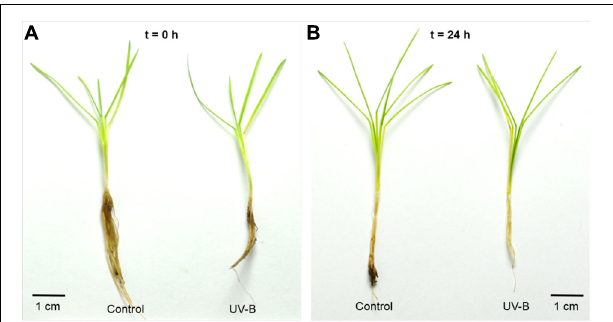
FIGURE 2 | Photographs of D. antarctica plants that were treated to a 1 day cycle of UVB radiation (UVB) in comparison with the control plants (Control) at the beginning of the experiment ( A ; t = 0 h) and after 24 h ( B ; t = 24 h). The scale bar indicates a length of 1